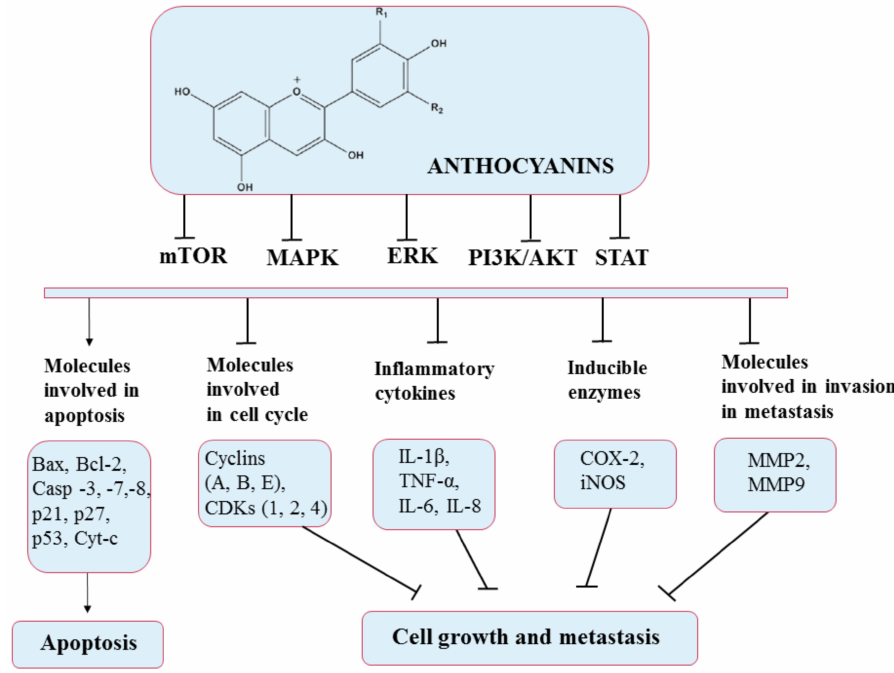
Figure 9. Chemical structure of anthocyanins and their mechanism of action through different molecular targets that result in apoptosis or suppressing growth and metastasis of